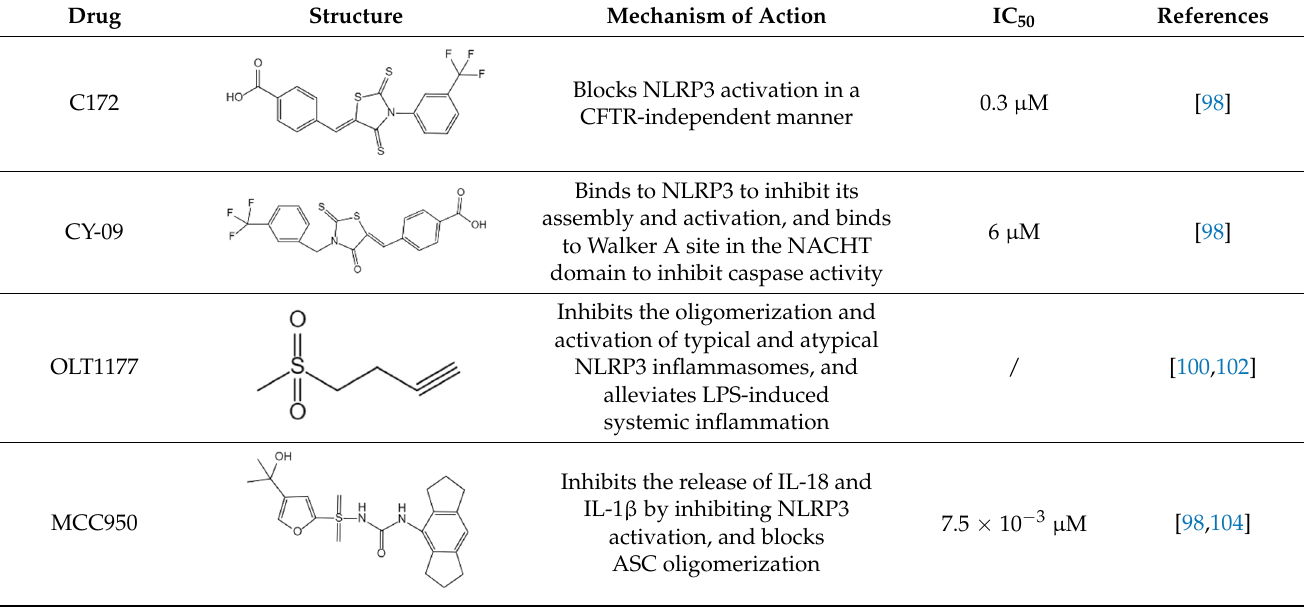
Table 1. Pyroptotic inhibitors targeted to NLRP3.